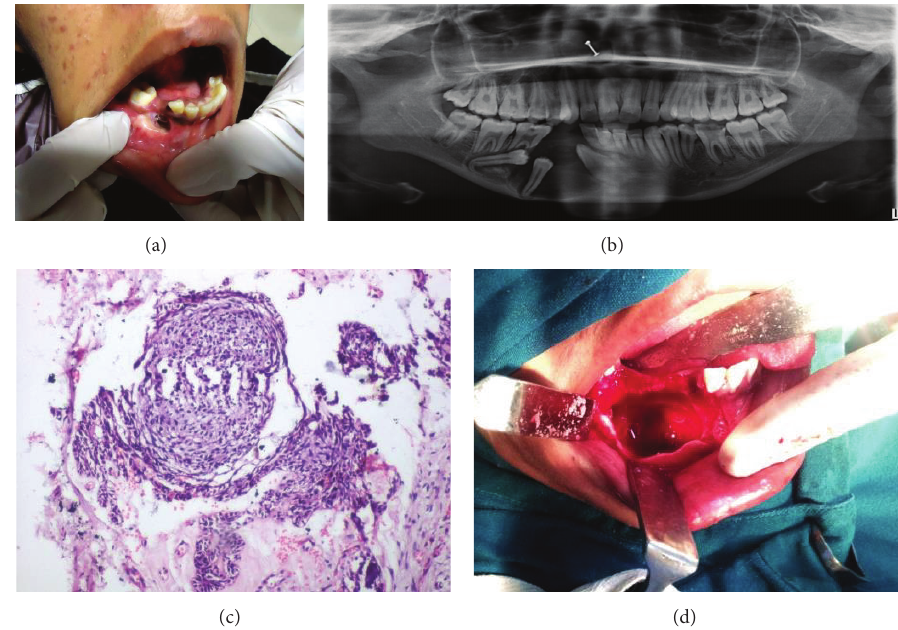
Figure 2: (a) Preoperative view. (b) OPG. (c) Unicystic mural ameloblastoma. (d) Intraoperative.